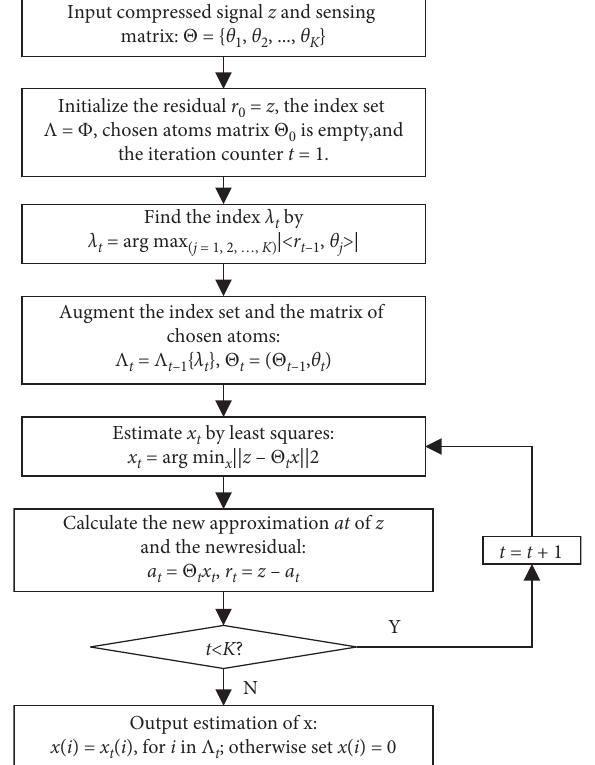
Figure 3: The flowchart of the OMP